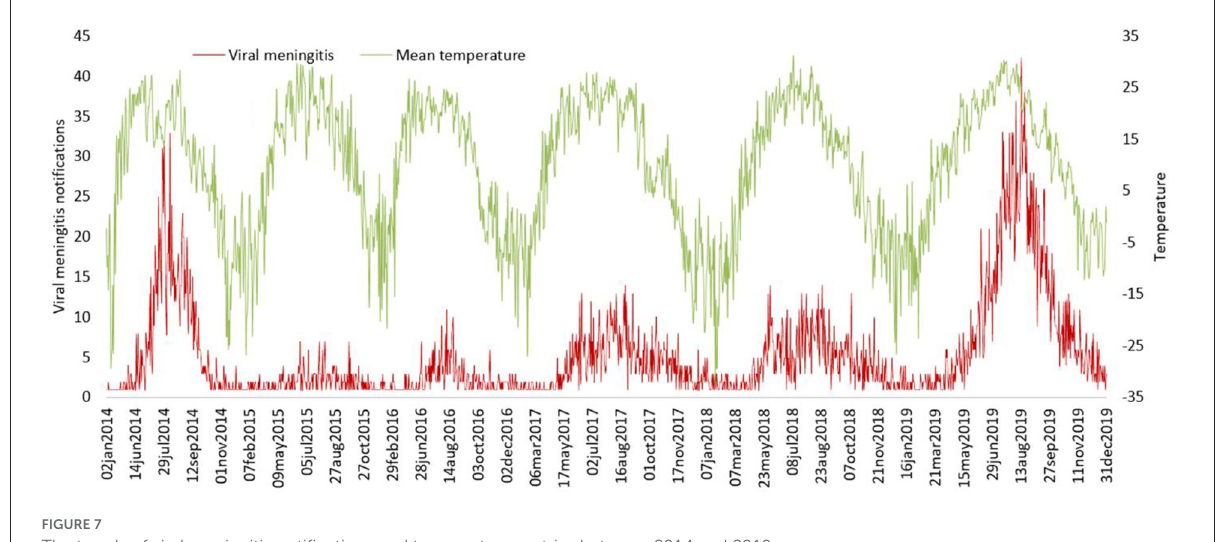
FIGURE7 The trends of viral meningitis notifications and temperature metrics between 2014 and